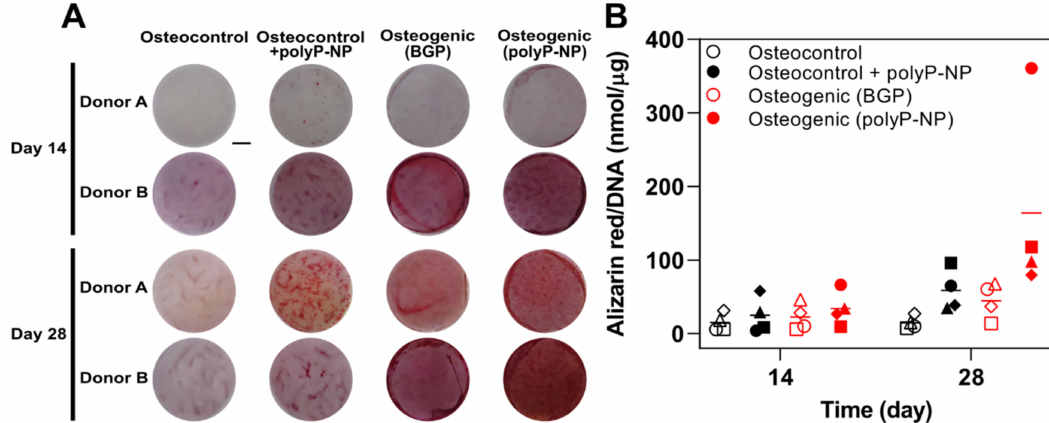
Figure 1. Alizarin red staining and quantification. ( A ) Representative images of Alizarin red staining of human bone-marrow-derived mesenchymal stem / stromal cells (BM-MSCs) at day 14 (upper panel) and day 28 (lower panel) from two independent donors are indicated for the four di ff erent treatments. Scale bar: 3 mm; ( B ) Quantification of Alizarin red staining normalised to DNA content for all donors. Individual data points shown are the mean of two technical replicates for each individual donor: donor A ( (cid:3) ), donor B ( ∆ ), donor C ( ♦ ) and donor D (o). The mean of the four independent donors within each group is indicated by the horizontal